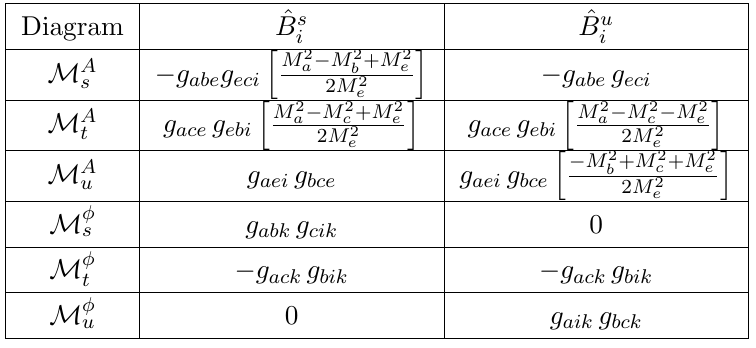
Table 7 . Coe(cid:14)cients ^ B i